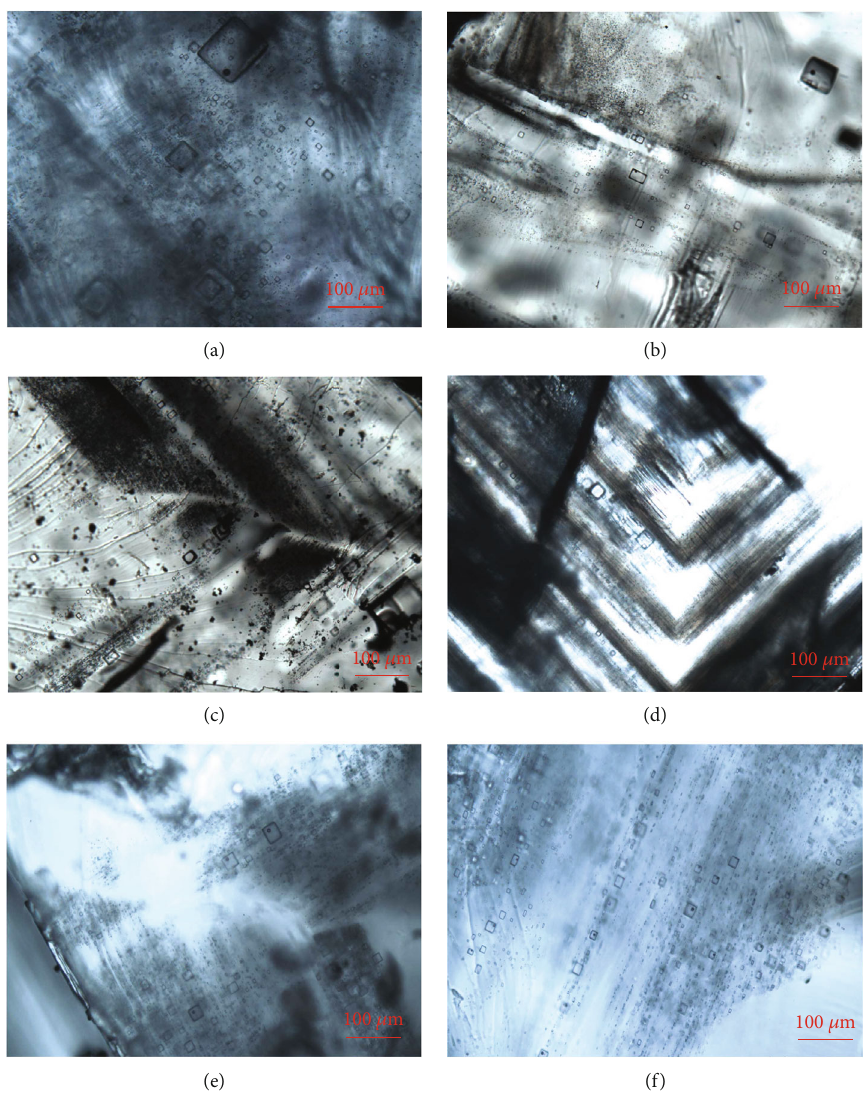
Figure 3: Petrologic characteristics of halite fl uid inclusions: (a, b) fl uid inclusion banding containing gas-liquid two-phase inclusion; (c, d) chevron fl uid inclusion banding distribution structure; (e, f) a large number of gas-liquid two-phase inclusions appear after freezing with liquid